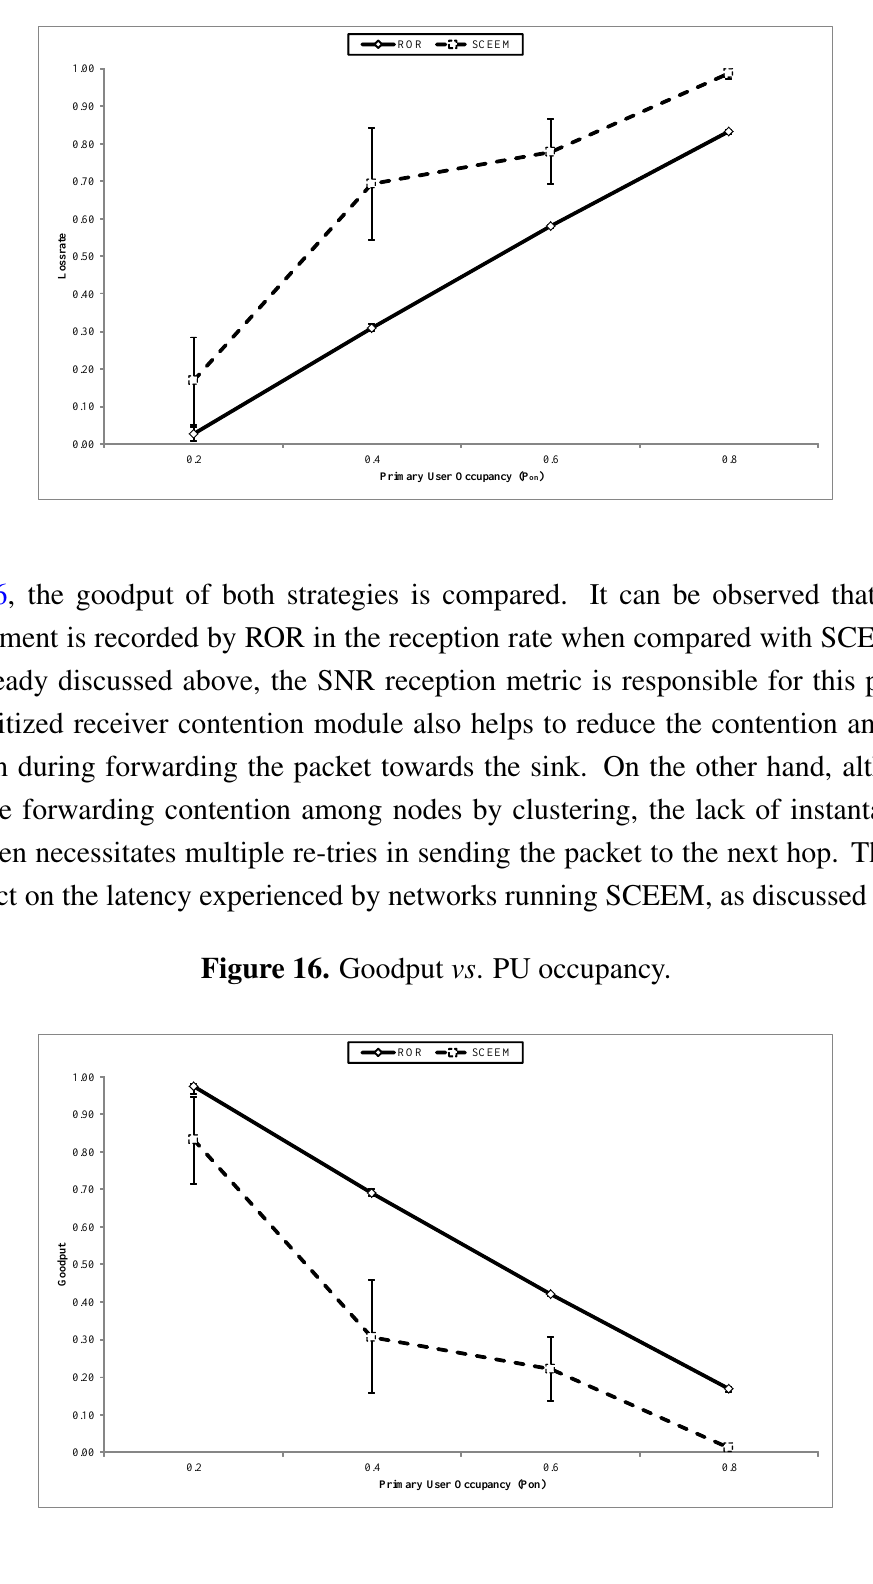
Figure 15. Loss rate vs . PU occupancy.